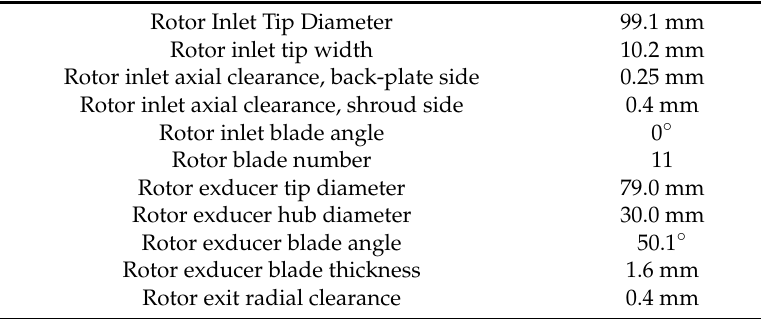
Table 1. Turbine geometrical